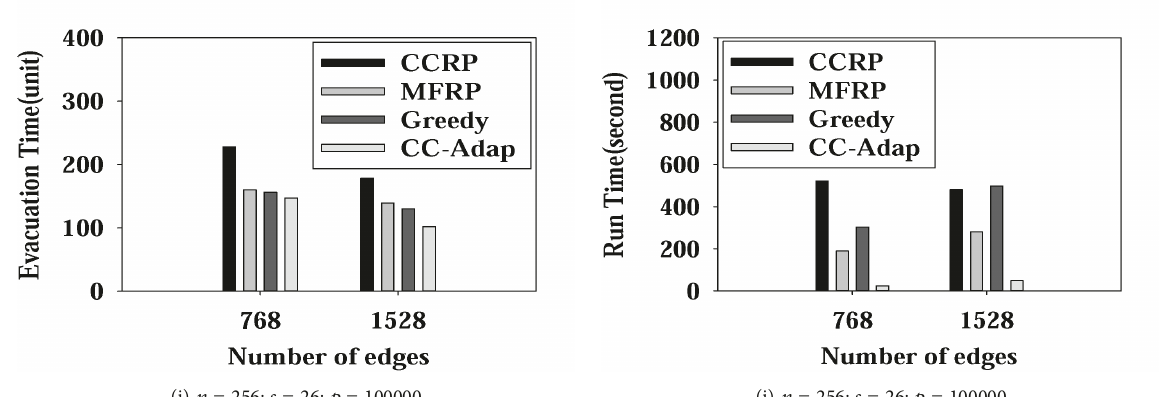
Figure 6: Evacuation quality with respect to the number of